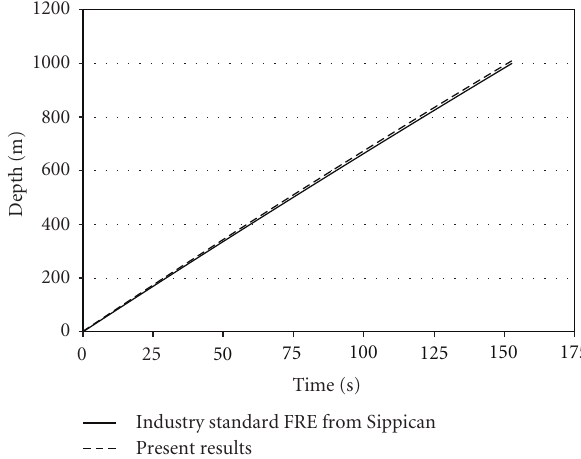
Figure 7: Comparison of depth calculated with the standard FRE and the new method.